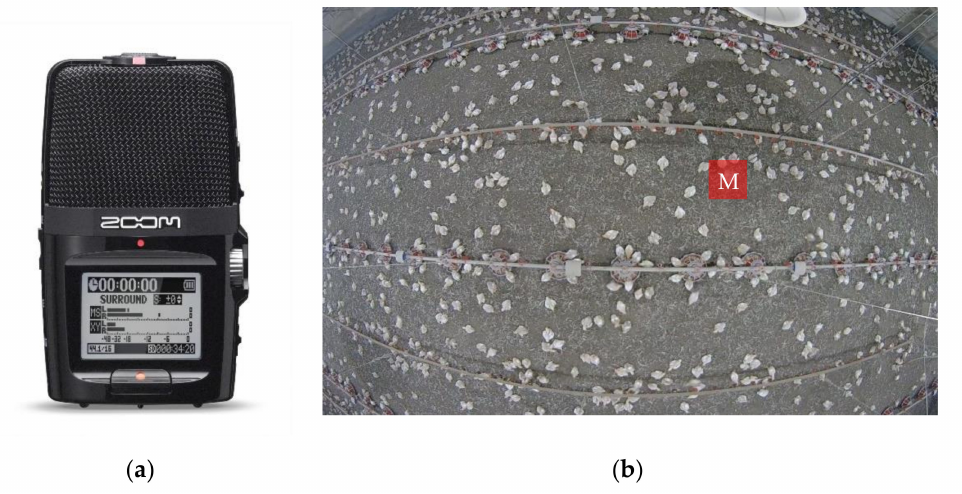
Figure 1. Image of the recorder ( a ) and location of the recorder M ( b ). A fisheye IP camera (Dahua, IPC-EW4431-ASW, Dahua Technology USA Inc., Irvine,